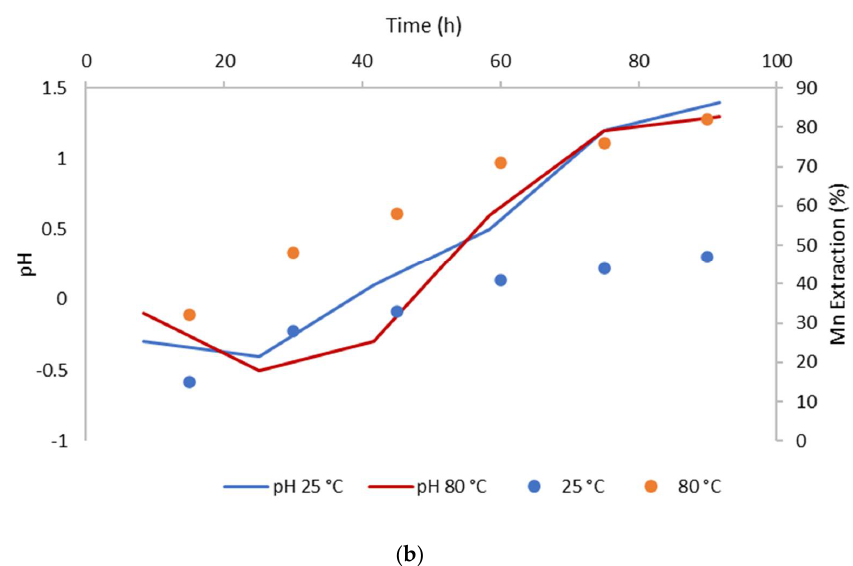
Figure 4. Dissolution of Fe and Mn over time from CuFeS 2 at room temperature (25 °C) and high temperature (80 °C) ( a ): dissolution of Fe and its behavior at changes in pH; ( b ): dissolution of Mn and its behavior at changes in pH).